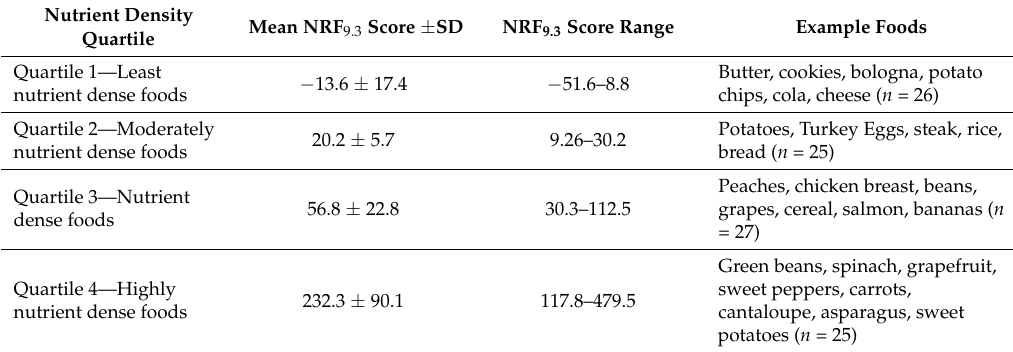
Table A3. Nutrient density quartiles based on NRF 9.3